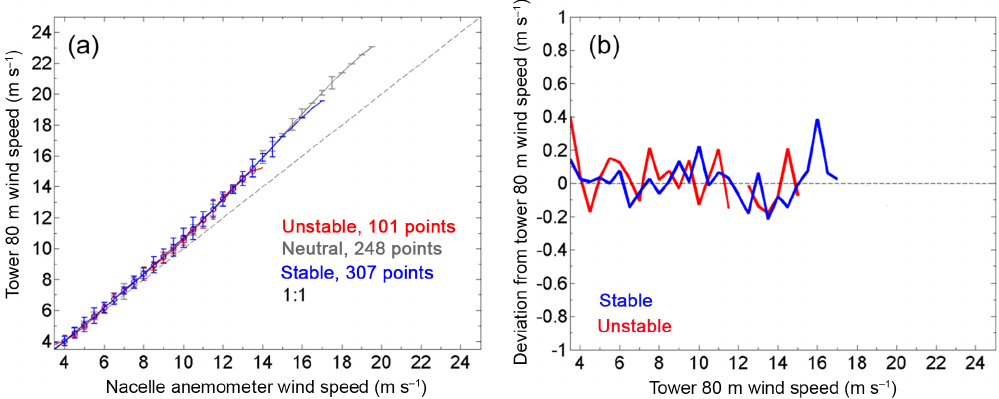
Figure 7. (a) Tower 80m NTFs calculated using fifth-order polynomial fits with stability regimes based on L . Error bars represent ± σ of the data within the same bins as the bins with which the NTFs are calculated. Statistically distinct differences within each wind speed bin between the stability classes are determined by the Wilcoxon rank sum test with a 1% significance level and denoted by closed circles. The figures include data filtered for tower 80m wind speeds between 3.5 and 25.0ms − 1 , 87m wind directions between 235 and 315 ◦ , and for normal turbine operation. (b) Average deviation in NTF-corrected nacelle-mounted anemometer wind speed from tower 80m wind speed is shown during stable conditions (blue) and during unstable conditions (red) versus tower 80m wind speed with stability regimes based on L . The dashed line indicates a 0ms − 1